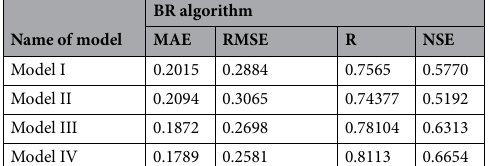
Figure 15. Graph of Correlation of Coefficient, R